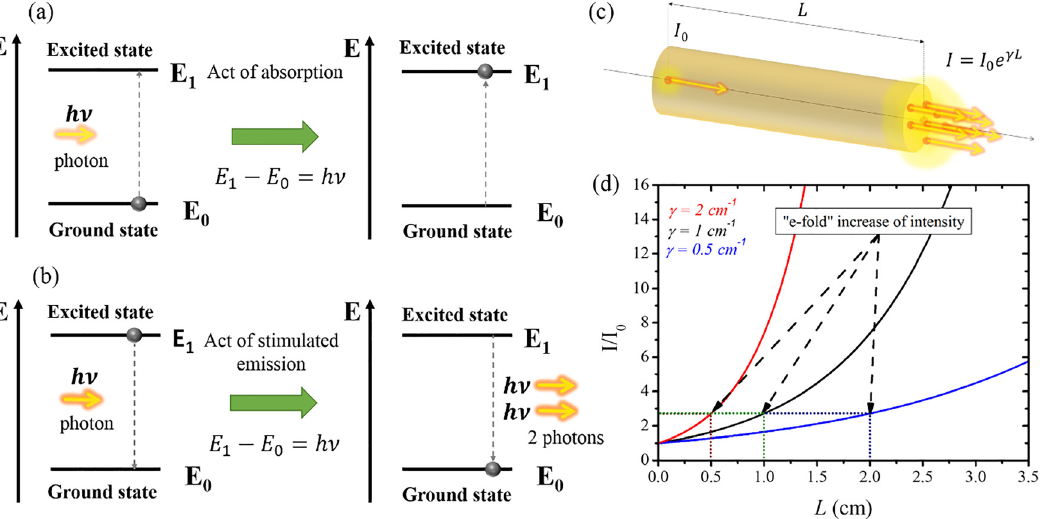
Figure1: Schemeofabsorption(a)andSTE(b)processesdepictedinenergydiagrams.Aschemeofampli fi cationoflightpropagatingthrough the gain medium (c). Different rates of intensity increase regarding different gain coef fi cients γ : 0.5, 1, and 2 cm − 1